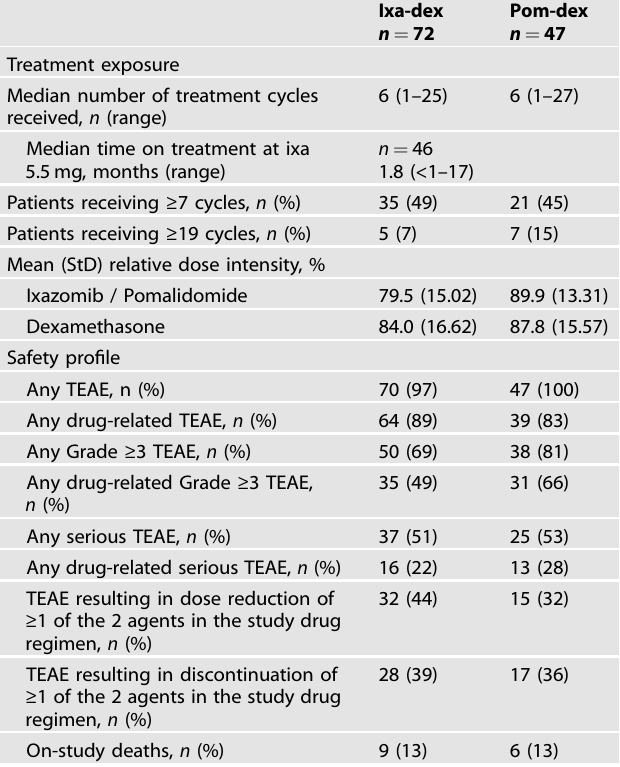
Table 3. Treatment exposure and overall safety pro fi le with ixa-dex and pom-dex in the safety